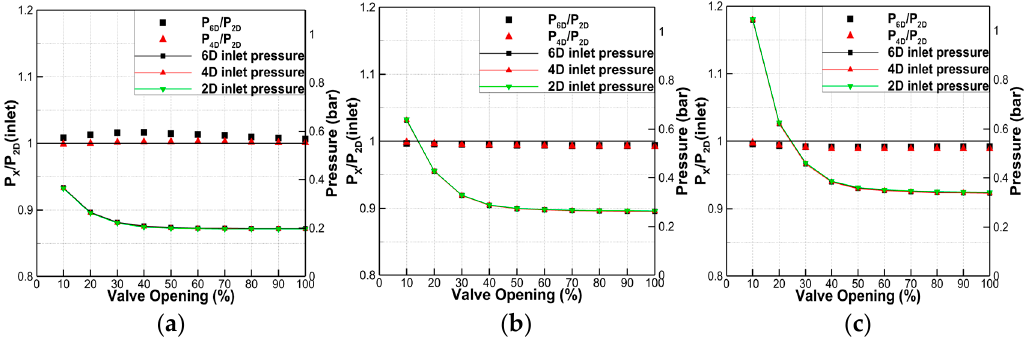
Figure 6. Comparison of pressure in the valve upstream: ( a ) 1000 RPM; ( b ) 1500 RPM; ( c ) 2000 RPM.